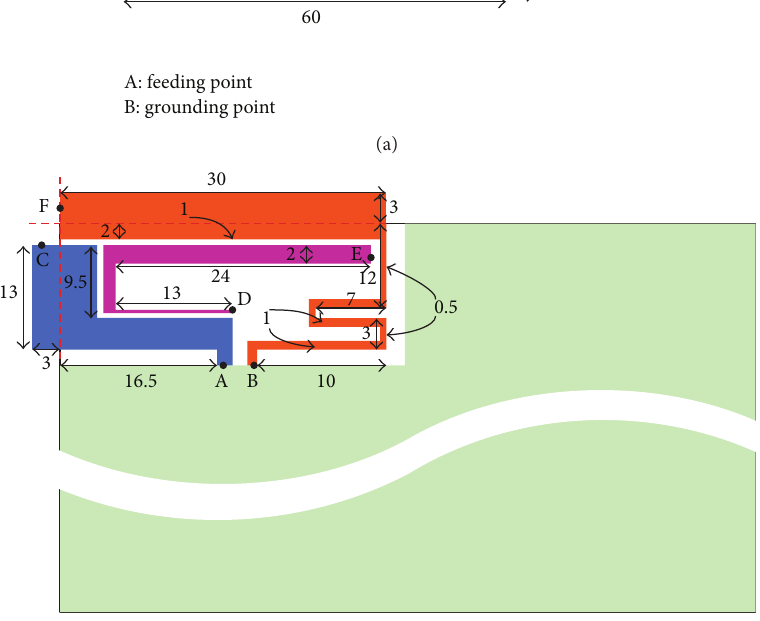
Since the satellite signal is weak, GNSS band needs to be covered in a higher standard. Usually in the standard of VSWR < 1.5 : 1 ( − 14 dB), the band is 1534 MHz–1668 MHz in the vicinity of GNSS band, which fully covers the four navigation system